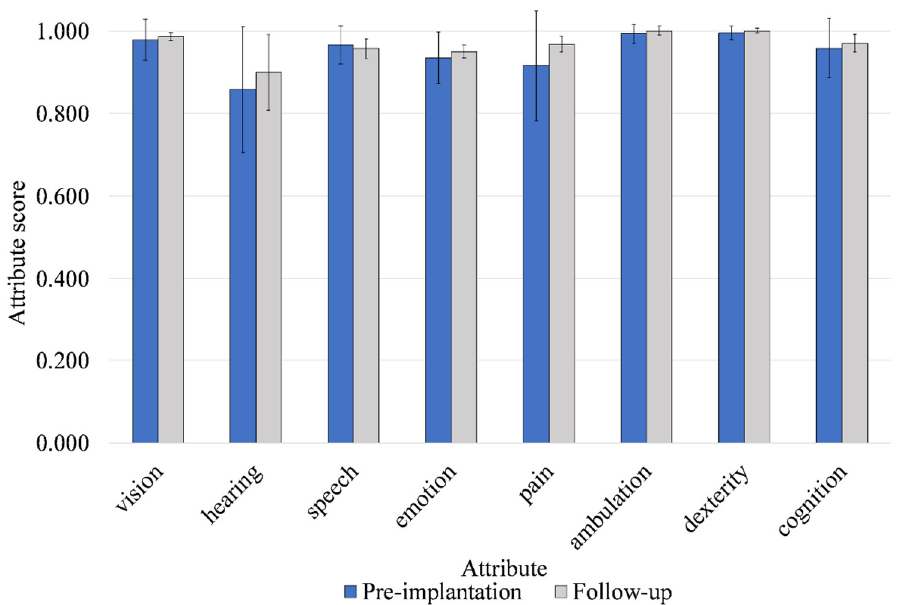
Figure 1. Mean HUI-3 single attribute scores pre-implantation and at 12-month follow-up ( n = 10). Error bars represent the standard deviation of the mean. The improvement in hearing and pain attribute was clinically relevant between pre-implantation and 12-month follow-up.